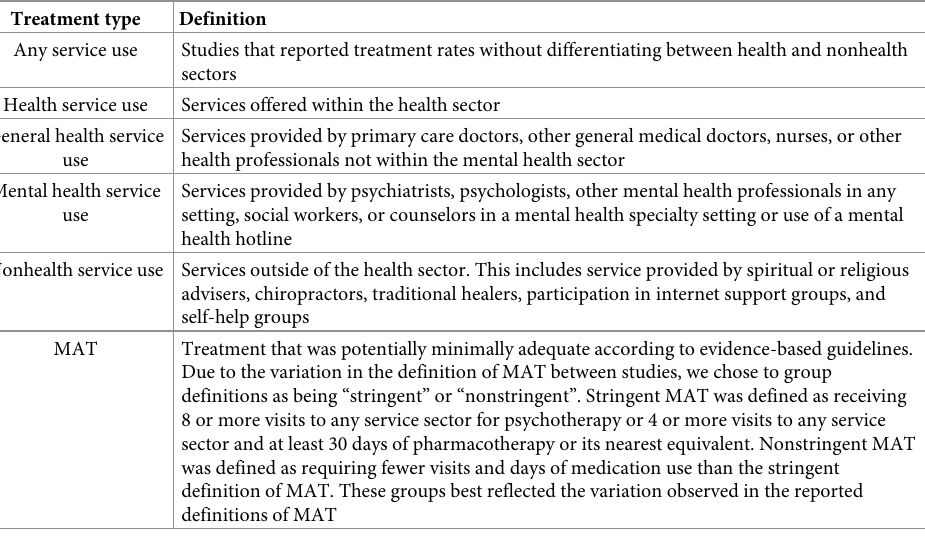
Table 1. Treatment types and corresponding